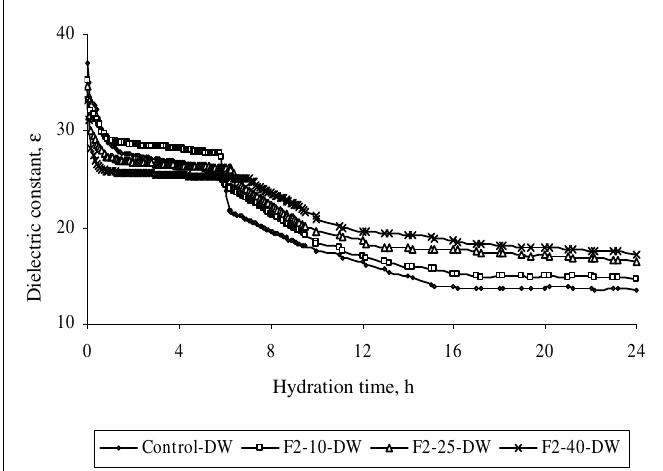
Figure. 3. Dielectric constant vs hydration time plot for control and F2 fly ash composites hydrated with